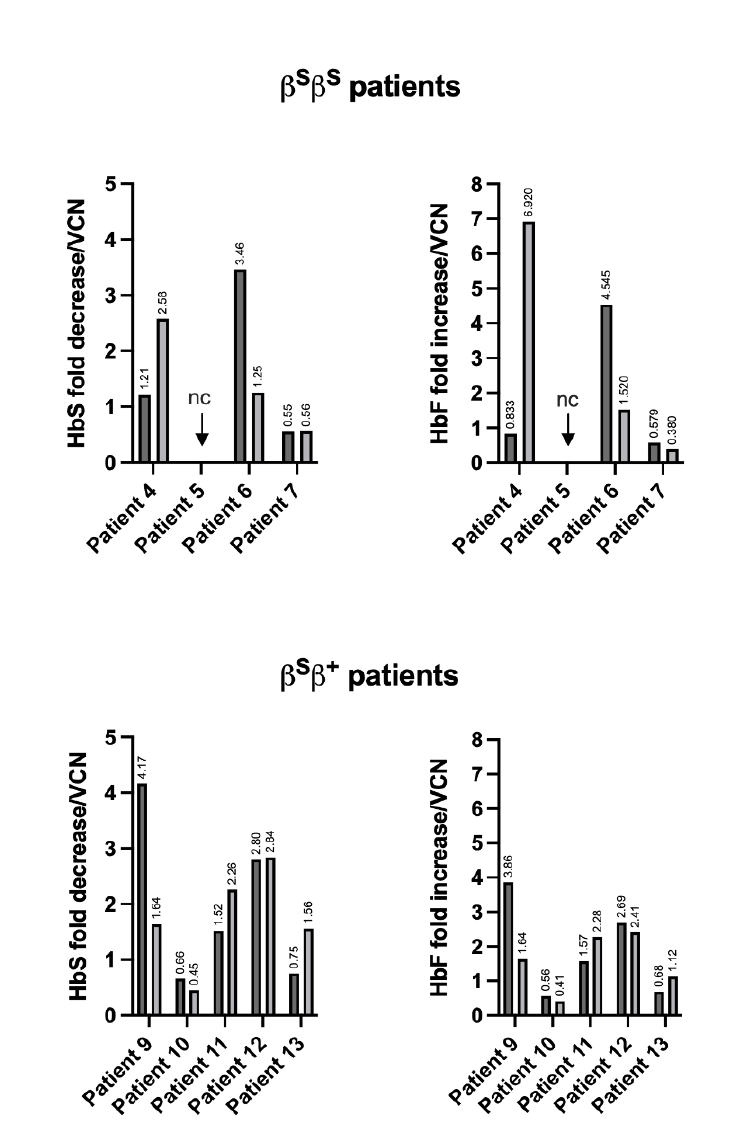
Figure 5. HbF and HbS fold difference in β S β S and β S β + SCD patients, post transduction: ( A ) Bar chart showing HbS fold decrease (left) and HbF fold increase (right) in β S β S patients following normalization to mean VCN/cell/patient; nc, not conducted. ( B ) Bar chart showing HbS fold decrease (left) and HbF fold increase (right) in β S β + patients following normalization to mean VCN/cell/pa- tient.